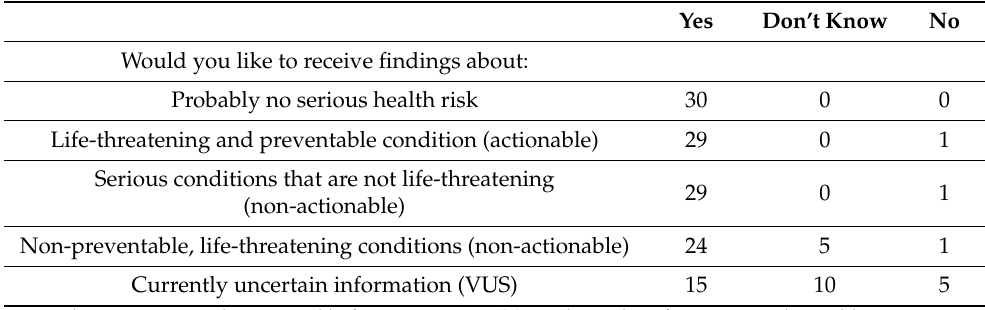
Table 5. Respondents’ attitudes towards receiving various categories of WGS findings (pre, n =